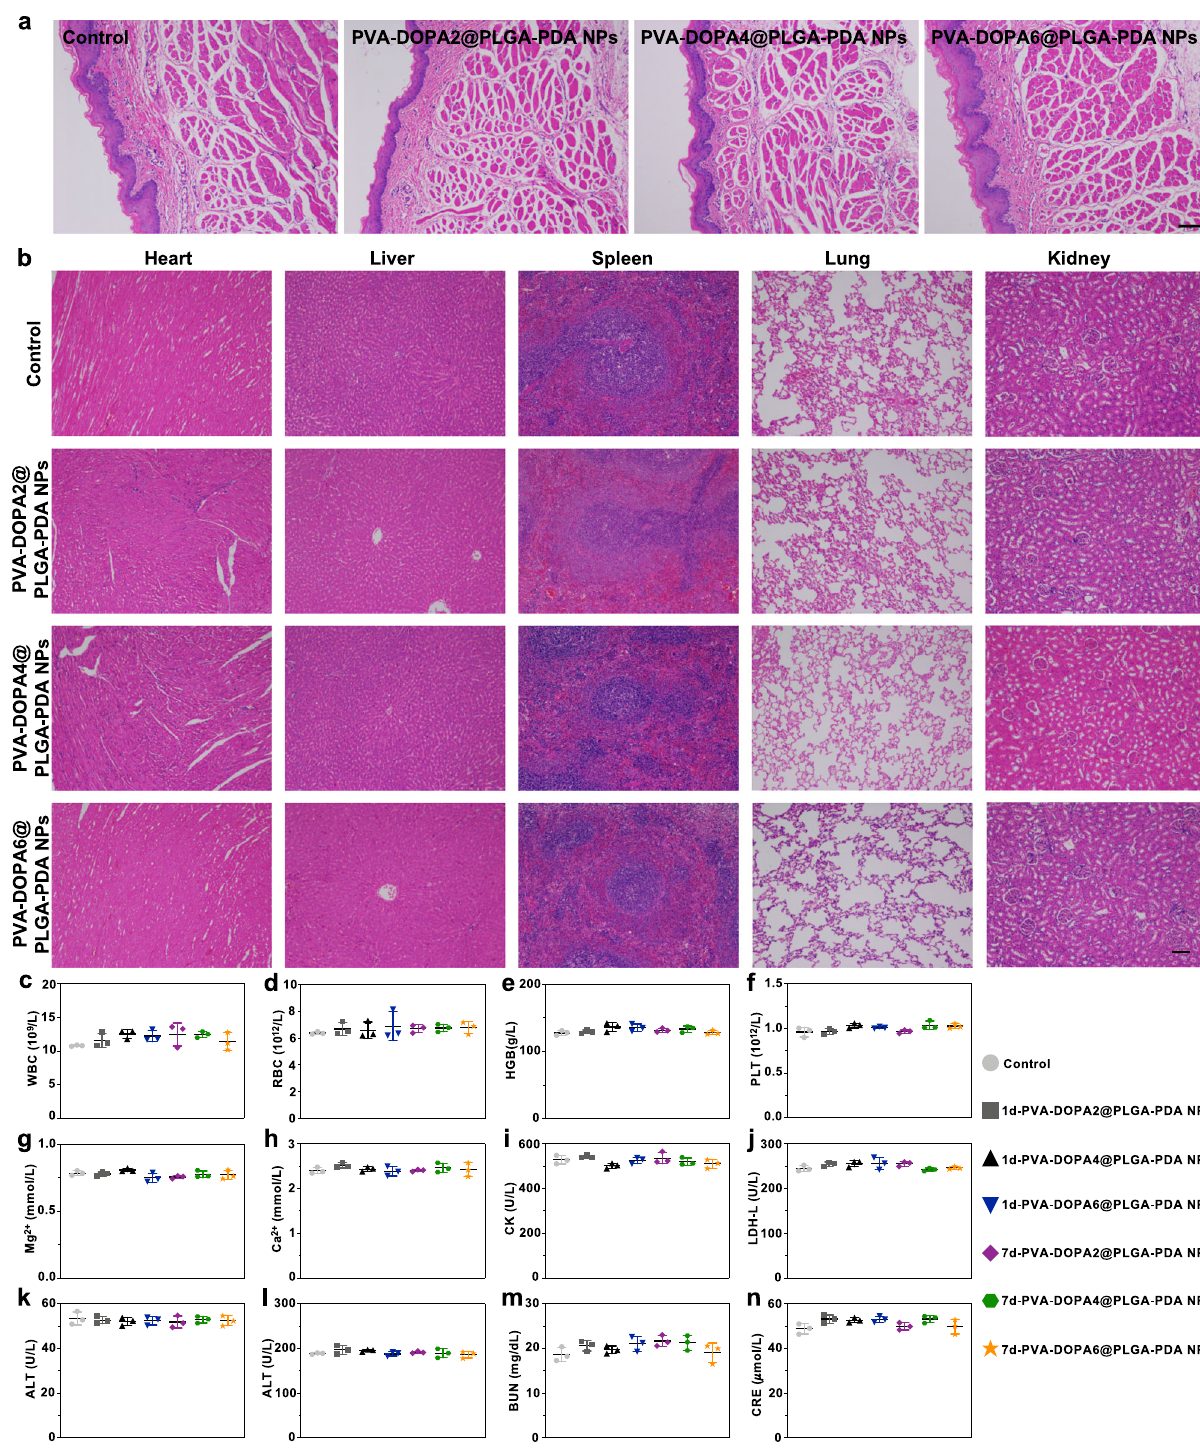
Fig. 7 In vivo biosafety evaluation. a Hematoxylin and erosion (H&E) staining of rat buccal mucosa tissue after application of different fi lms for 4 h. PVA: poly(vinyl alcohol), DOPA: 3,4-dihydroxy-D-phenylalanine, PLGA: poly(lactic-co-glycolic acid), PDA: polydopamine. Scale bar: 100 μ m. b H&E staining of major organs (the heart, liver, spleen, lung, and kidney) after subcutaneous implantation of different fi lms in the backs of Sprague Dawley rats for 1 day. Scale bar: 100 μ m. c – f Hematological examination of the variation in WBC (red blood cell count), RBC (white blood cell count), HGB (hemoglobin), and PLT (platelet count) after subcutaneous implantation of different fi lms in the backs of Sprague Dawley rats for 1 or 7 days. g – n Blood biochemistry examination of the variation in Mg 2 + , Ca 2 + , CK (creatine kinase), LDH-L (lactate dehydrogenase), ALT (alanine transferase), AST (aspartate transferase), BUN (blood urea nitrogen), and CREA (creatinine) after subcutaneous implantation of different fi lms in the backs of Sprague Dawley rats for 1 or 7 days. All data are Mean± S.D. n = 3 animals per group. Statistics was calculated by one-way ANOVA followed by Tukey ’ s post-test. Source data are provided as a Source data fi